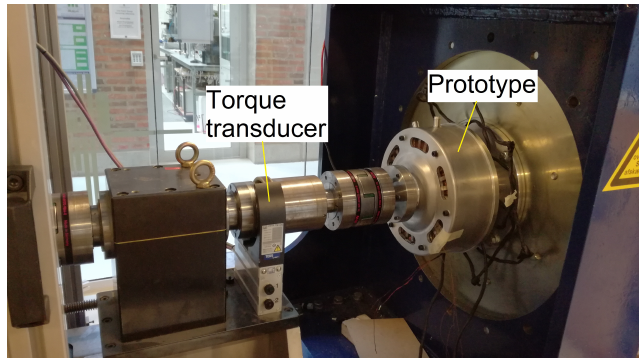
Figure 20. Test set-up as